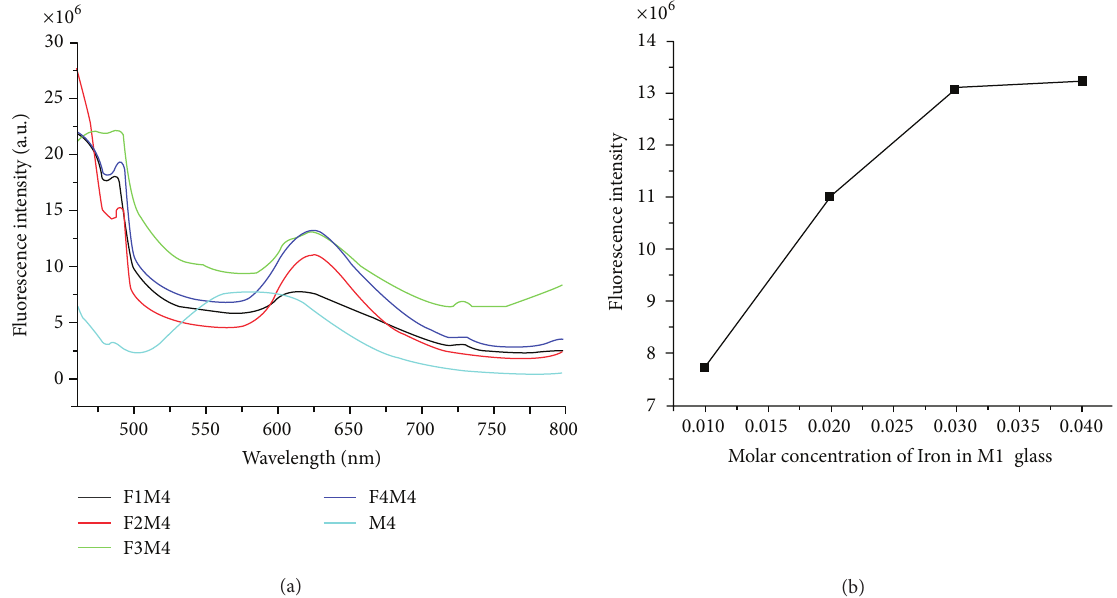
Figure 6: (a) Photoluminescence spectra of Fe-MG SiO 2 glasses (F1M4, F2M4, F3M4, and F4M4) and M4 glass. (b) Variation of photoluminescence intensity with molar concentration of Fe-I in F 𝑥 M4 glasses ( 𝑥 = 1 – 4 ).